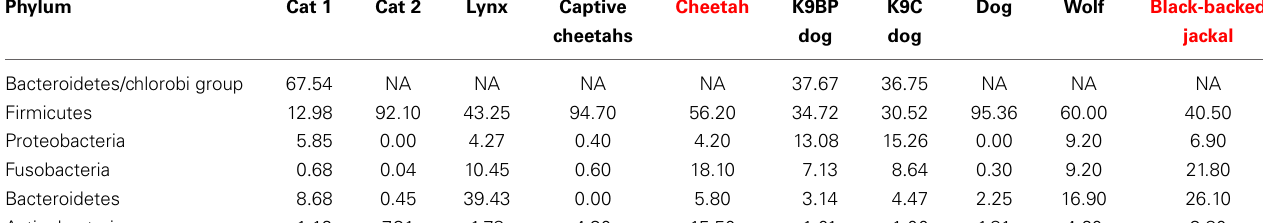
Table 1 | Proportions (%) of dominant phyla present in domestic cats (cat 1: Tun et al., 2012; cat 2: Handl et al., 2011), free-ranging Iberian lynx ( Lynx pardinus , Alcaide et al., 2012) and captive cheetahs (Becker et al., 2014), domestic dogs (K9BP dog and K9C dog: Swanson et al., 2010; dog: Handl et al., 2011) and free-ranging wolf ( Canis lupus , Zhang and Chen, 2010) and profiles for cheetah (red) and black-backed jackal (red) of this study.